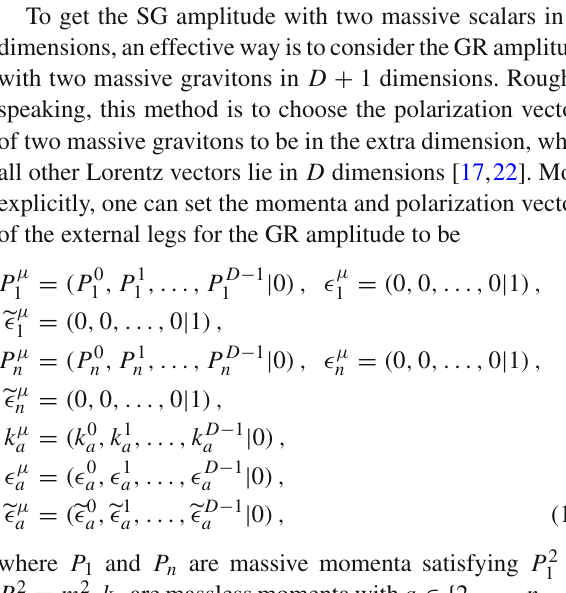
˙ <α 0 ˙ < · · · ˙ <α 0 | 0 |− 1 2 3